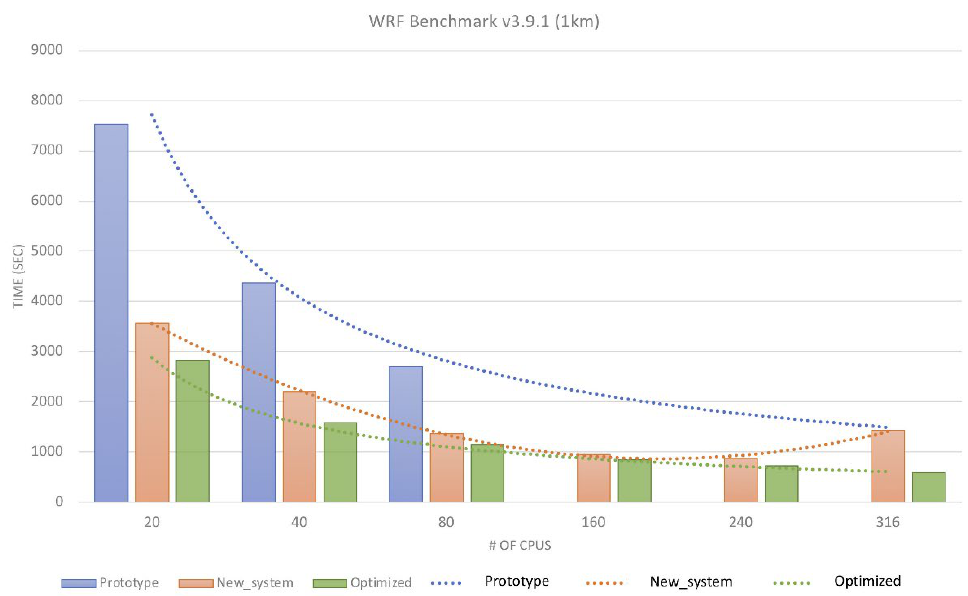
Figure 7. Comparison of WRF efficiency for various systems at high resolution (1 km). Blue, PW; orange, RPW; green, IRPW.